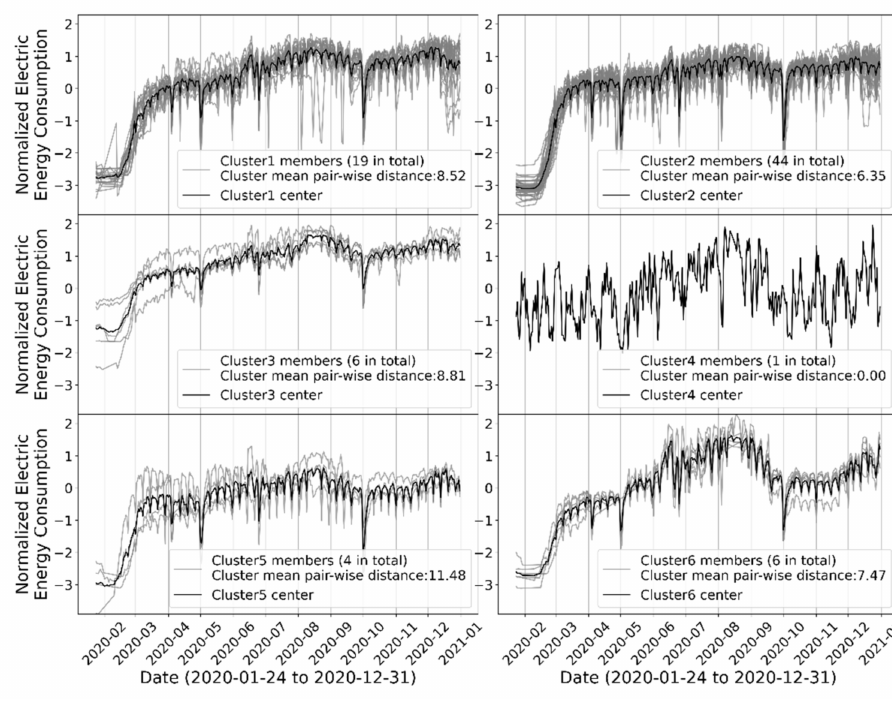
Figure 13. Clustering result for the dataset of the COVID-19 period.